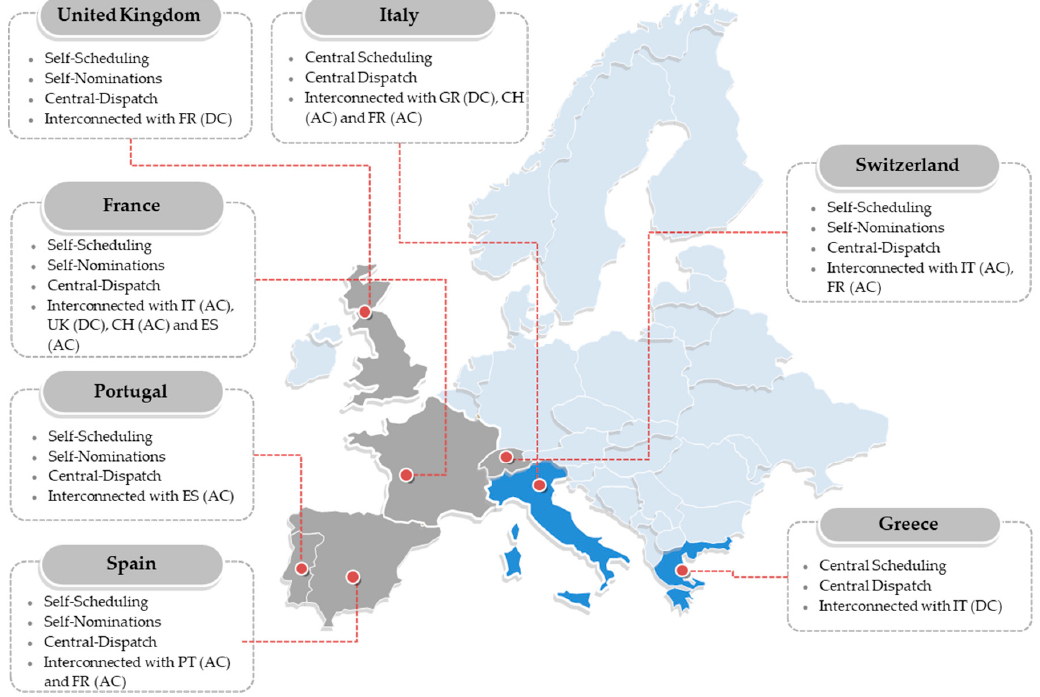
Figure 10. European balancing energy markets included in the test case.